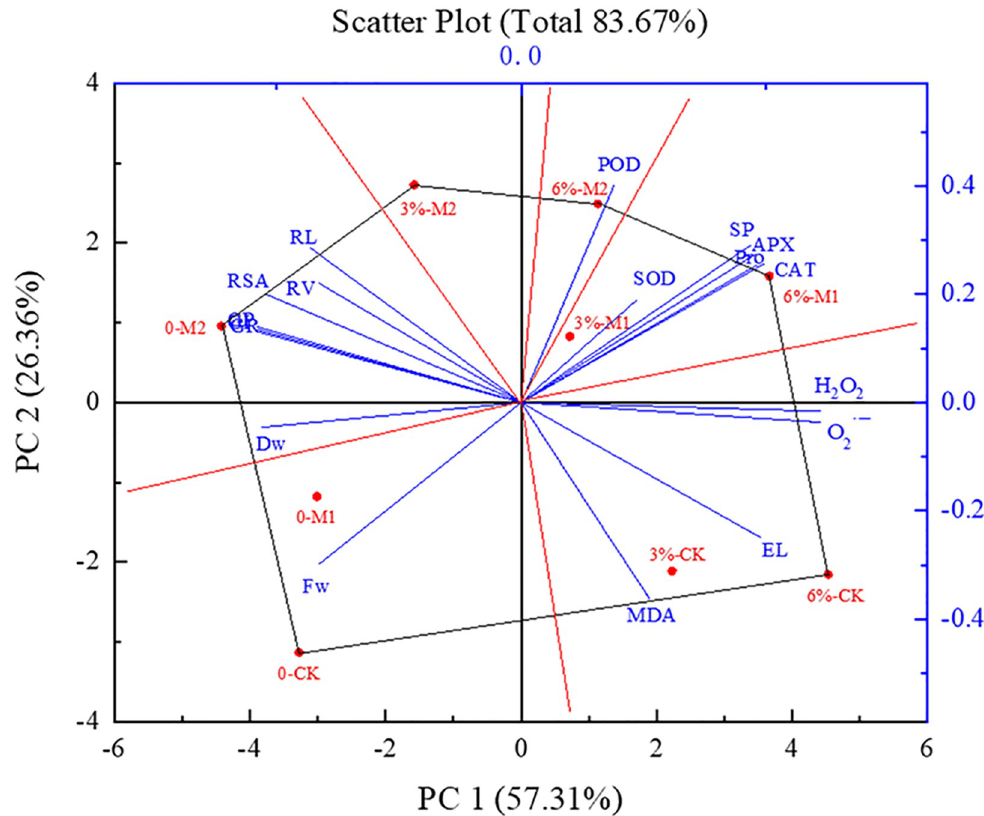
Fig 9. Analysis of all indicators of soybean seeds based on GGE biplot under different treatments.